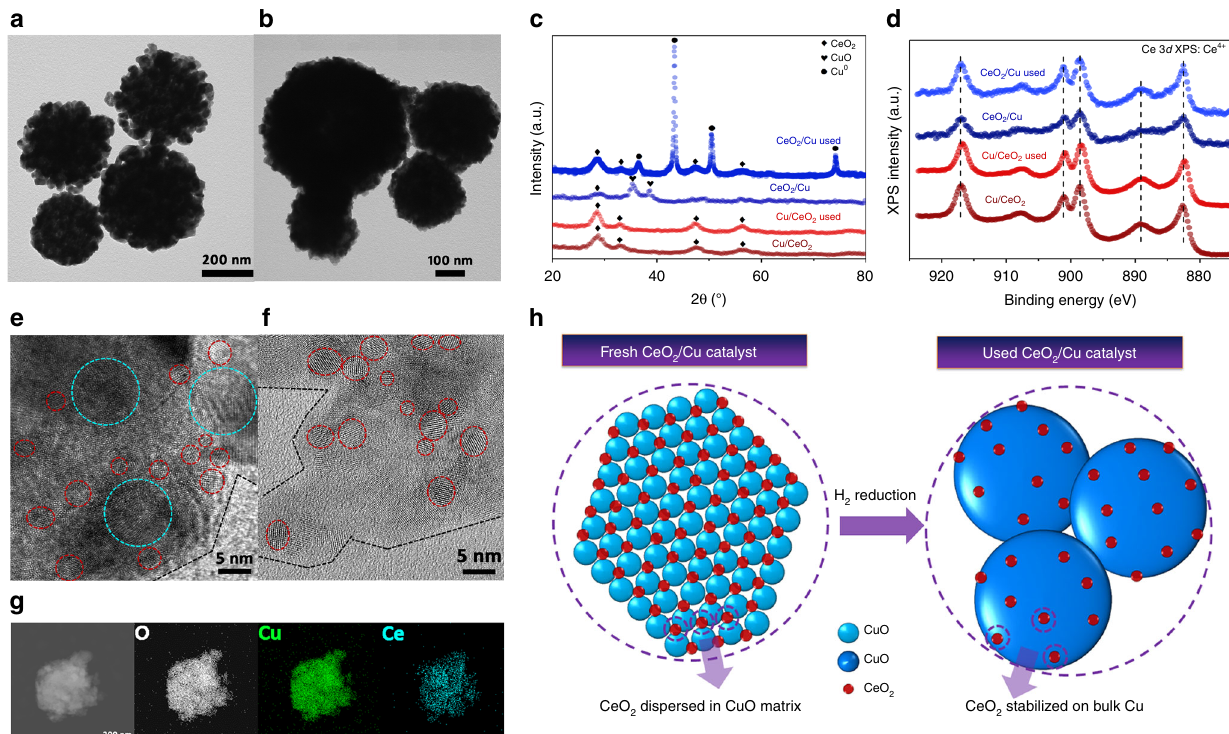
Fig. 2 Structure evolution of inverse CeO 2 /Cu catalyst during WGS reaction. a , b Transmission electron microscope (TEM) images of a fresh and b used inverse CeO 2 /Cu catalysts. c X-ray diffraction (XRD) patterns of the fresh and used catalysts. d Ce 3 d X-ray photoelectron spectroscopy (XPS) results of the fresh and used catalysts. e , f High-resolution TEM (HR-TEM) images of fresh e and used f inverse CeO 2 /Cu catalyst, red circles re fl ect to CeO 2 , blue circles re fl ect to CuO. g Scanning transmission electron microscope (STEM) image and element mapping results of used inverse CeO 2 /Cu catalyst, the inset bar: 200 nm. h Scheme of structural evolution for inverse CeO 2 /Cu catalyst during WGS reaction, CeO 2 nanoparticles are well stabilized despite Cu